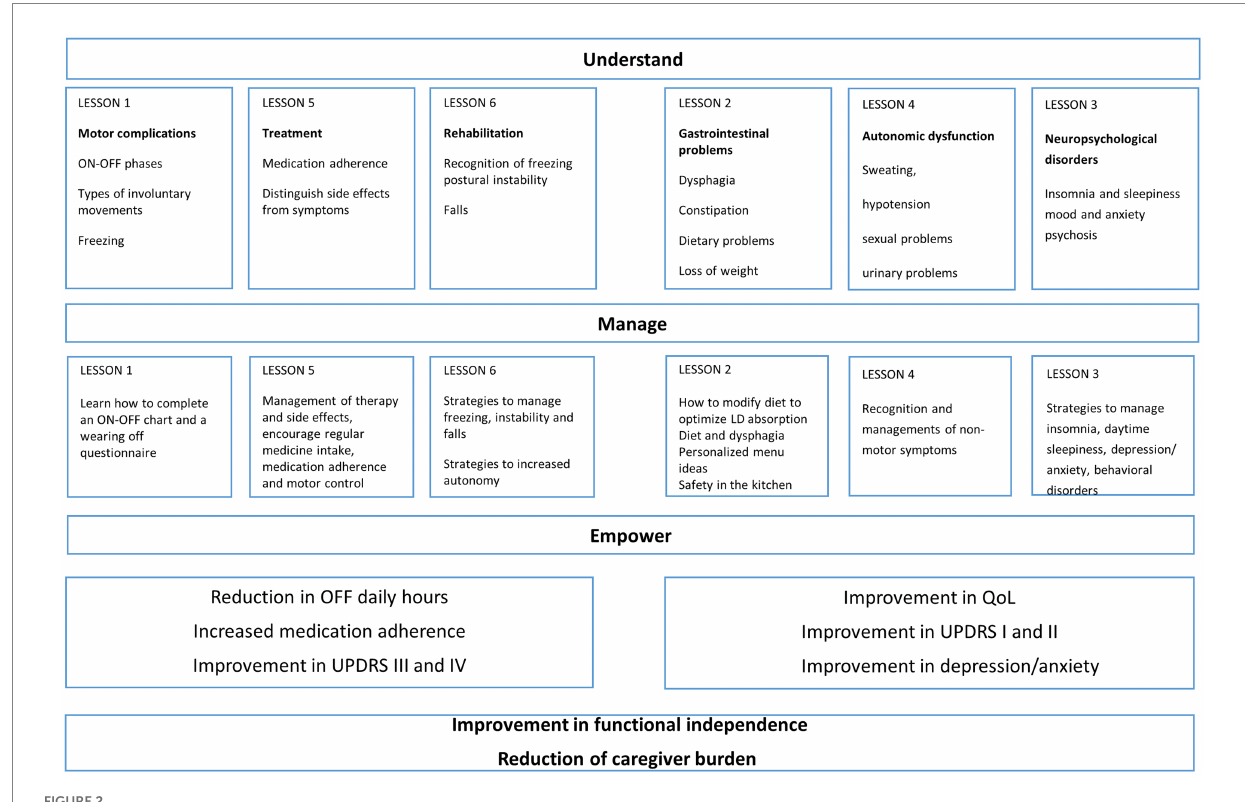
FIGURE 2 Diagram with topics of the six sessions of Parkinson’s disease (PD) educational program: in the diagram are illustrated the topics of the six sessions, divided in motor and non-motor outcomes. The aim of the program was to increase understanding of the disease, guide self-management, empower patients and caregivers and increasing their capacity to act on disease